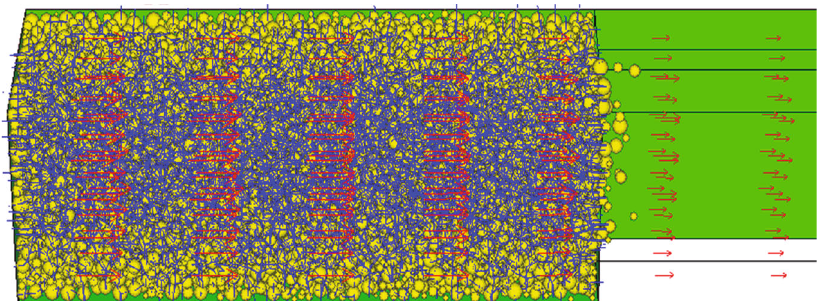
Figure 6: Model diagram of a moment of particle equilibrium disruption.